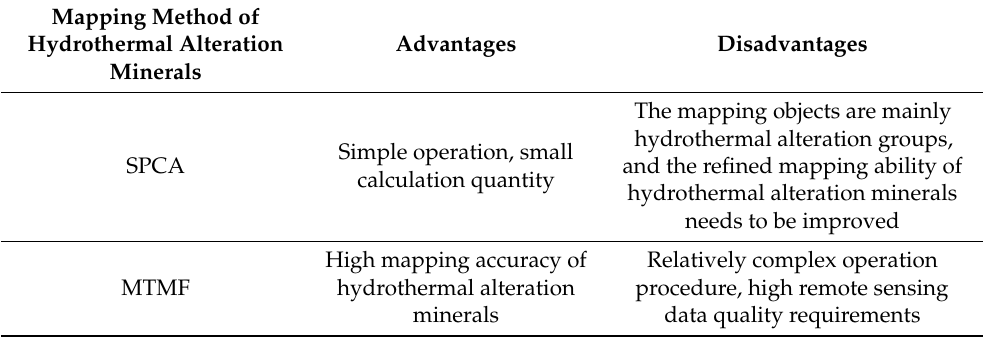
Table 1. Comparison of the advantages and disadvantages between SPCA and MTMF